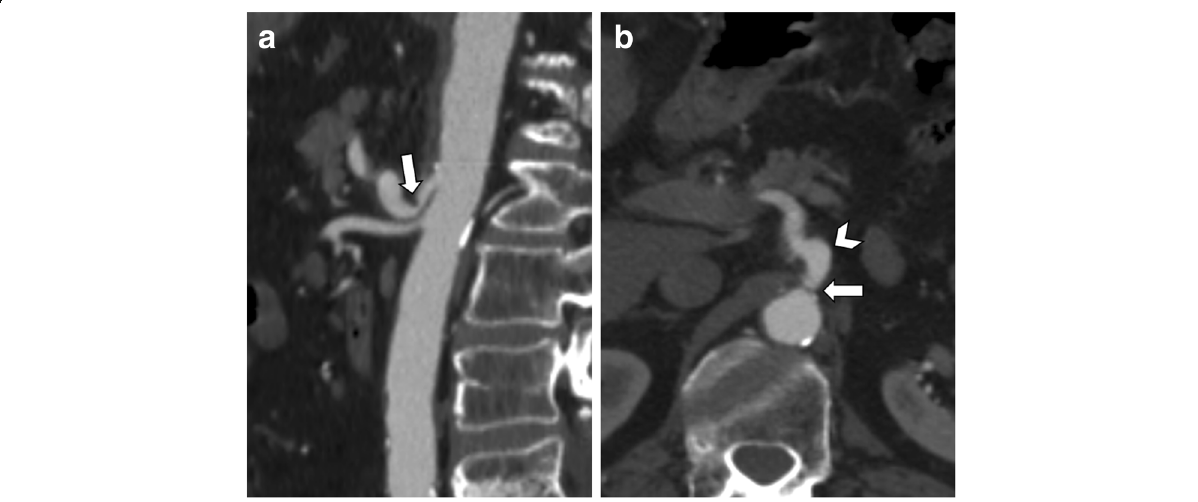
Fig. 2 A 65-year-old man with median arcuate ligament compressing the celiac artery. a Sagittal CT image shows the “ hooked appearance ” (arrow) with severe stenosis at the origin of the celiac artery, in the absence of atherosclerotic plaques. b Corresponding axial CT image shows celiac artery compression (arrow) with post-stenotic dilatation